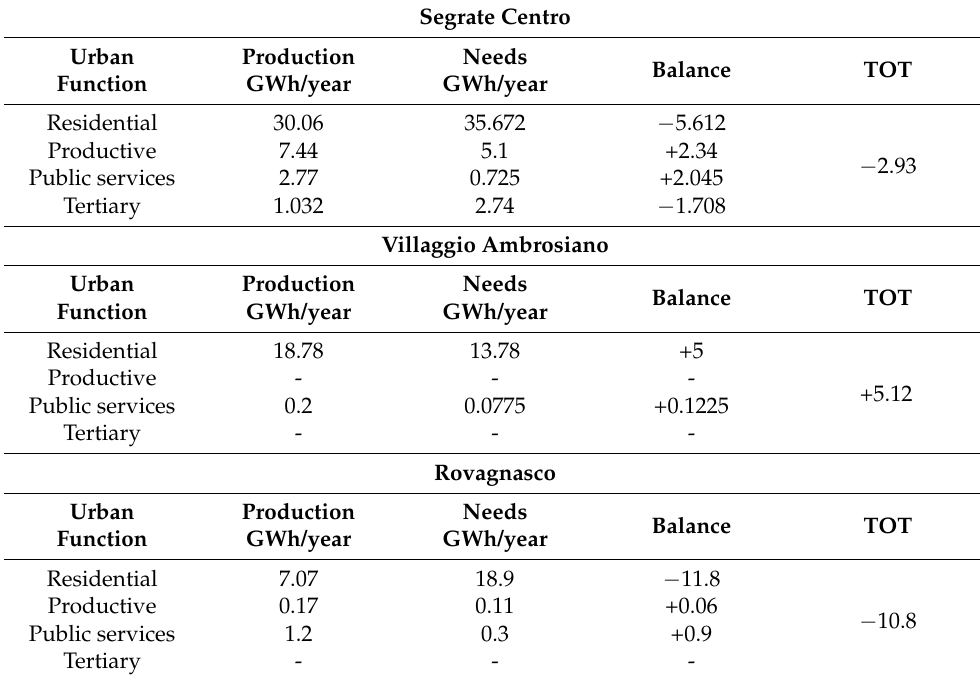
Table 8. Final energy balance in the case study’s